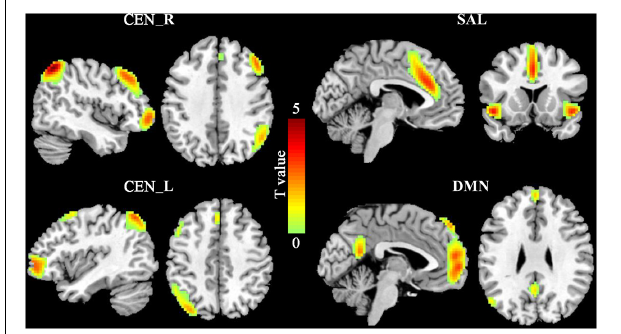
FIGURE 1 | The triple networks. The group independent component analysis (ICA) was used to define the triple networks. Four subcomponents of the triple networks were identified including default mode network (DMN), salience network (SAL), and left and right central executive network (CEN_L, CEN_R).